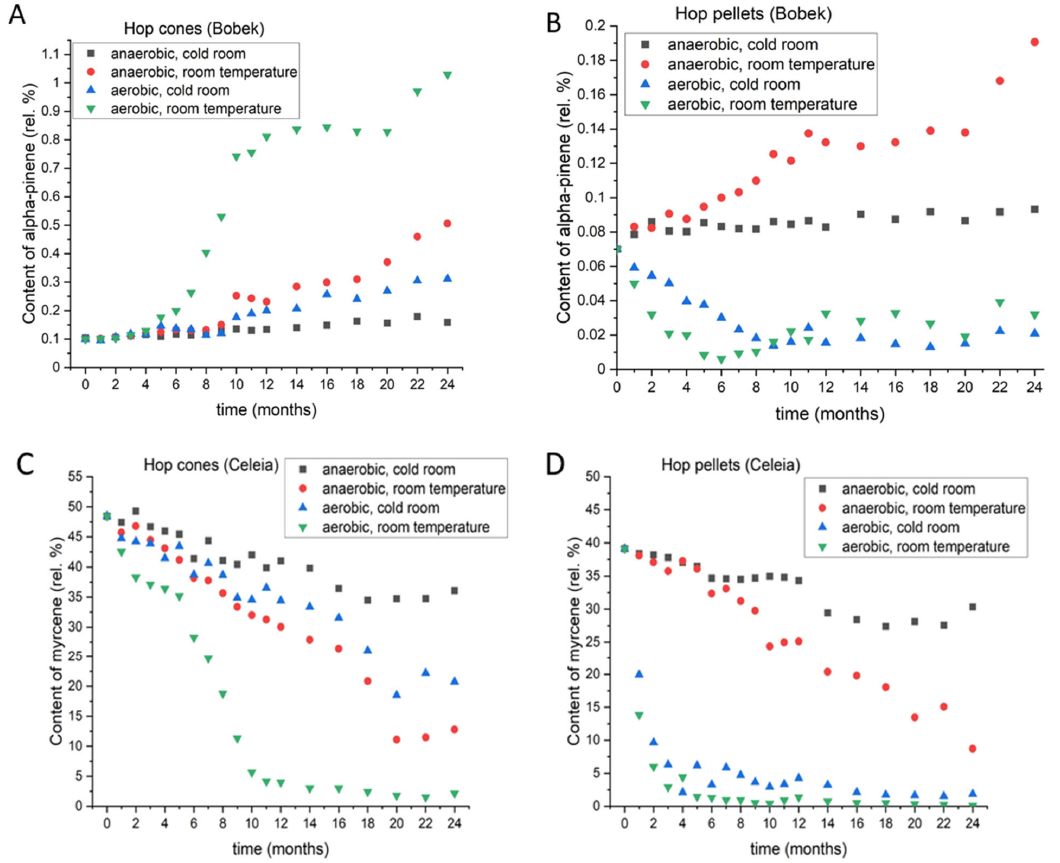
Figure 4. Changes in the content of alpha-pinene in Bobek cones ( A ) and pellets ( B ) and changes in the content of myrcene in Celeia cones ( C ) and pellets ( D ) during two-year period, under different storage conditions.